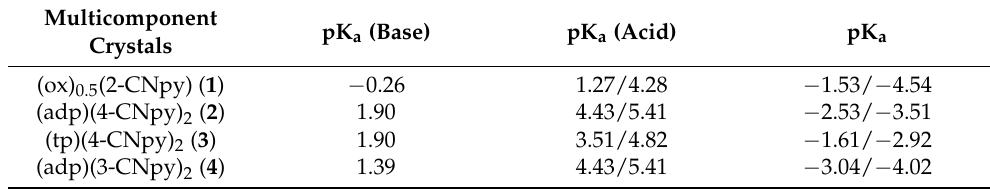
Table 2. pK a and ∆ pK a values of multicomponent crystals ( 1 – 4